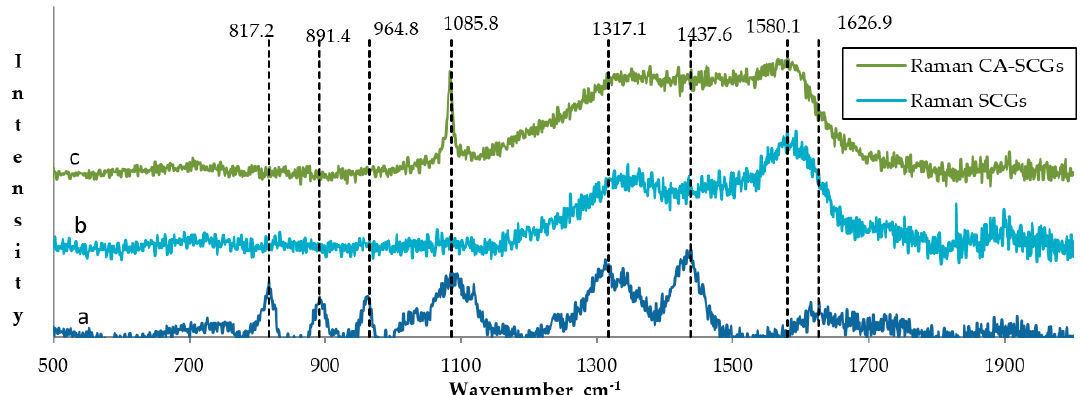
Figure 3. Comparison of the Raman spectra of ( a ) CA beads, ( b ) SCGs and ( c ) CA–SCGs beads.